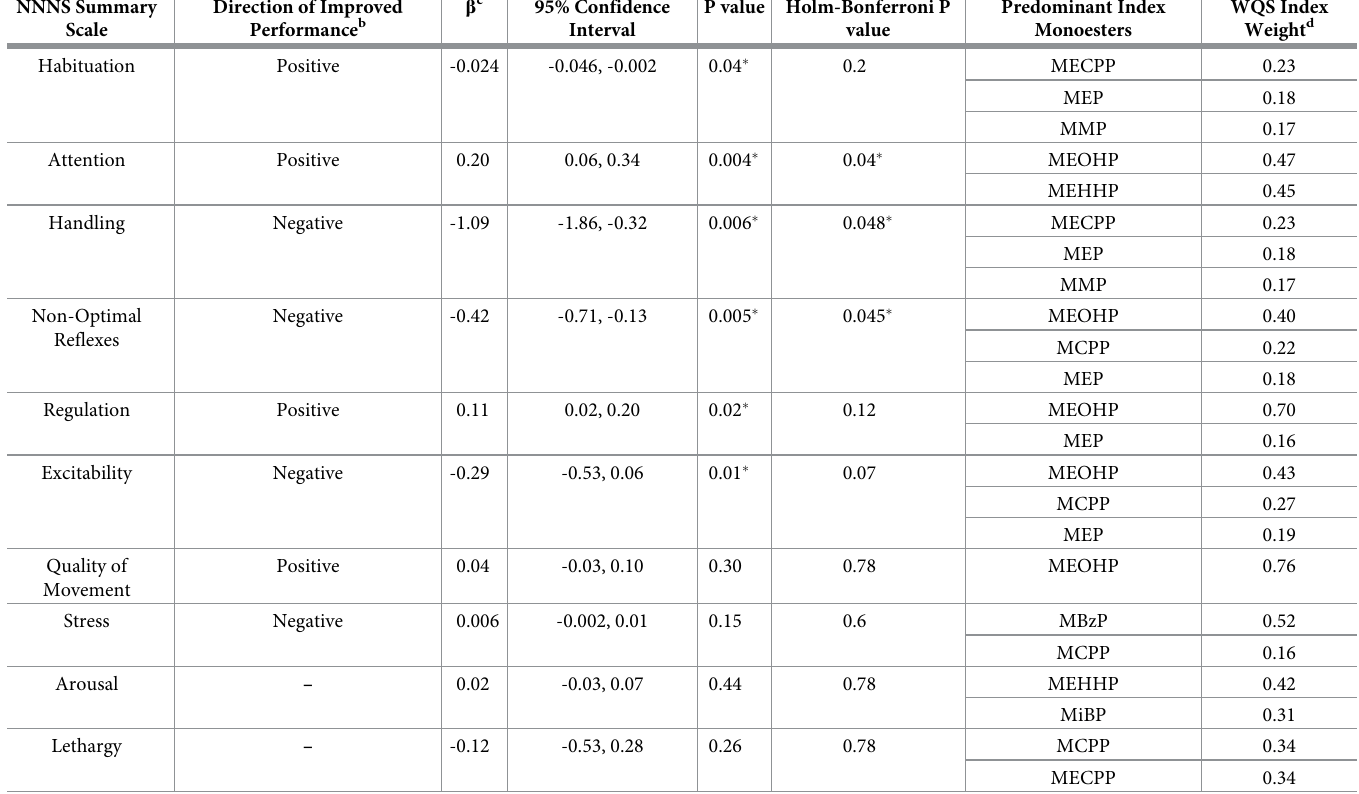
Table 6. Association of outcome-specific weighted indices of phthalate biomarkers with summary scale performance on the NICU Network Neurobehavioral Scale a . NNNS Summary